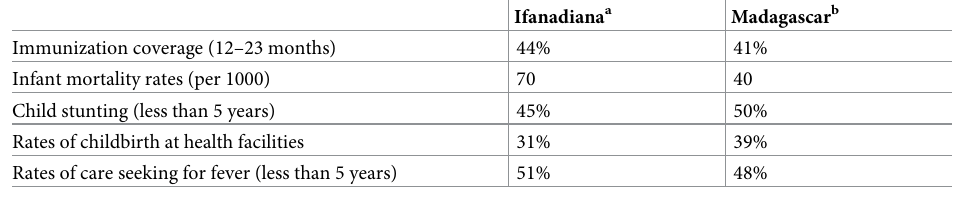
Table 1. Comparison of key child health metrics for Ifanadiana district and